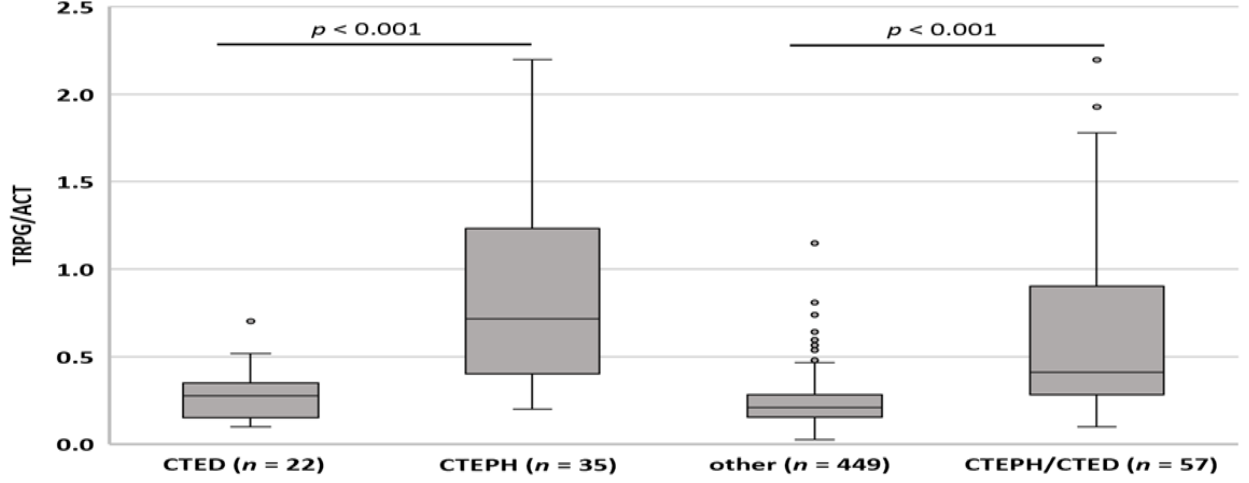
Figure 2. Distribution of TRPG/AcT parameter across groups. CTEPH — chronic thromboembolic pulmonary hypertension; CTED — chronic thromboembolic disease, TRPG/AcT tricuspid regurgitation peak gradient/pulmonary ejection acceleration time.